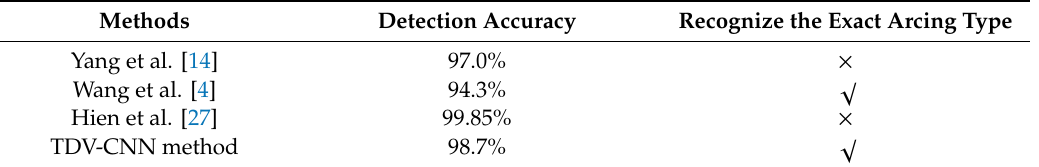
Table 5. Properties comparison with prior